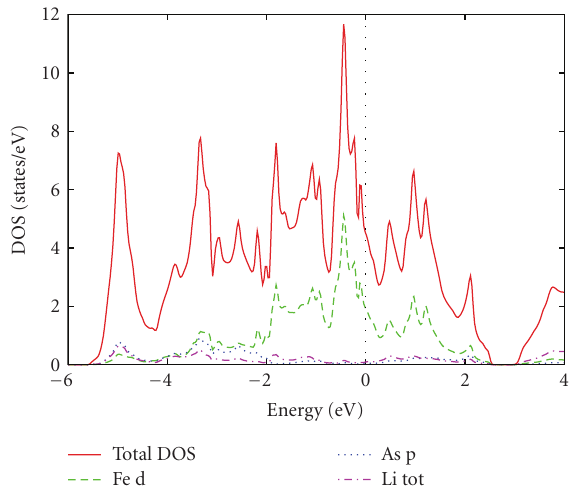
Figure 1: Density of states (DOSs) in LiFeAs. Both the total and atomic DOSs are shown. The Fermi energy is the zero energy. Near the Fermi energy, the DOS is dominated by the Fe 3d